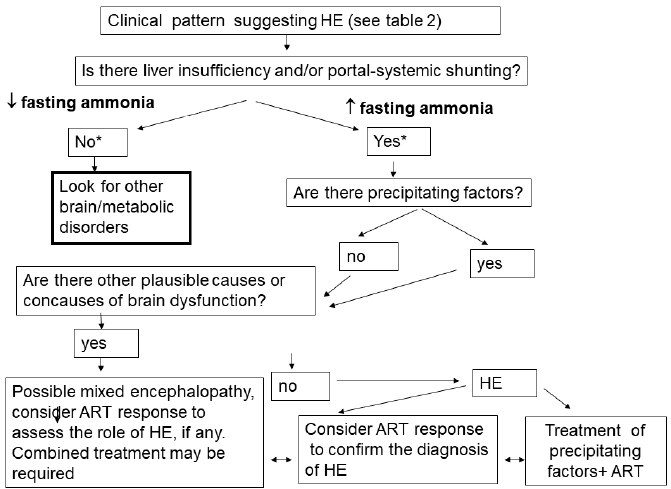
Figure 2. Flow chart for the diagnosis of hepatic encephalopathy (HE) (modified from [50]). ART: ammonia-reducing treatment (non-absorbable antibiotic ± disaccharides). * Low ammonia is con- sidered to have high negative predictive value for HE [8], since it suggests: (1) relatively good liver function, (2) negligible portal-systemic shunting, and (3) negligible gut dysbiosis in cirrhosis.